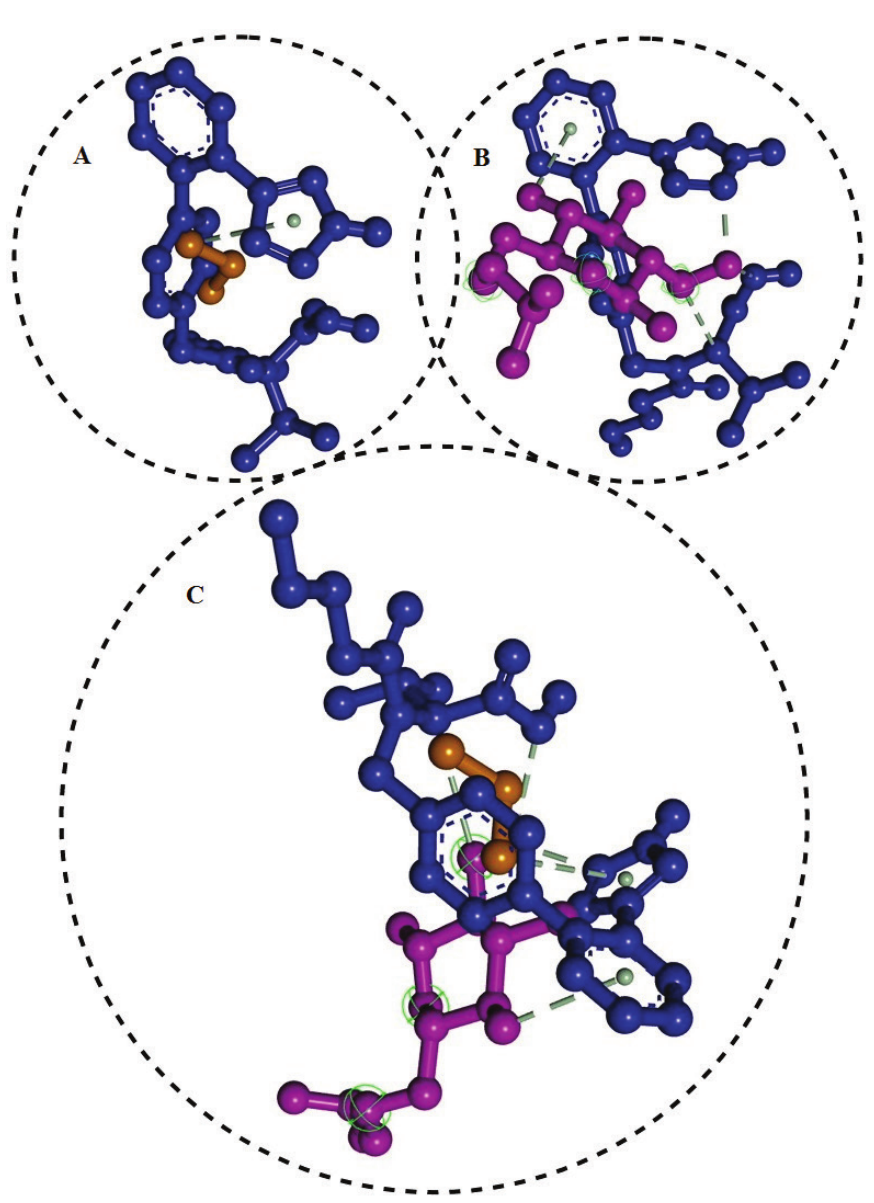
Fig. 4 – Computational study of VAL-Aerosil 200 (a), HPMC-VAL (b), HPMC-VAL-Aerosil 200 (c); where HPMC (dark peach) – VAL (dark blue) – Aerosil 200 (dark yellow)